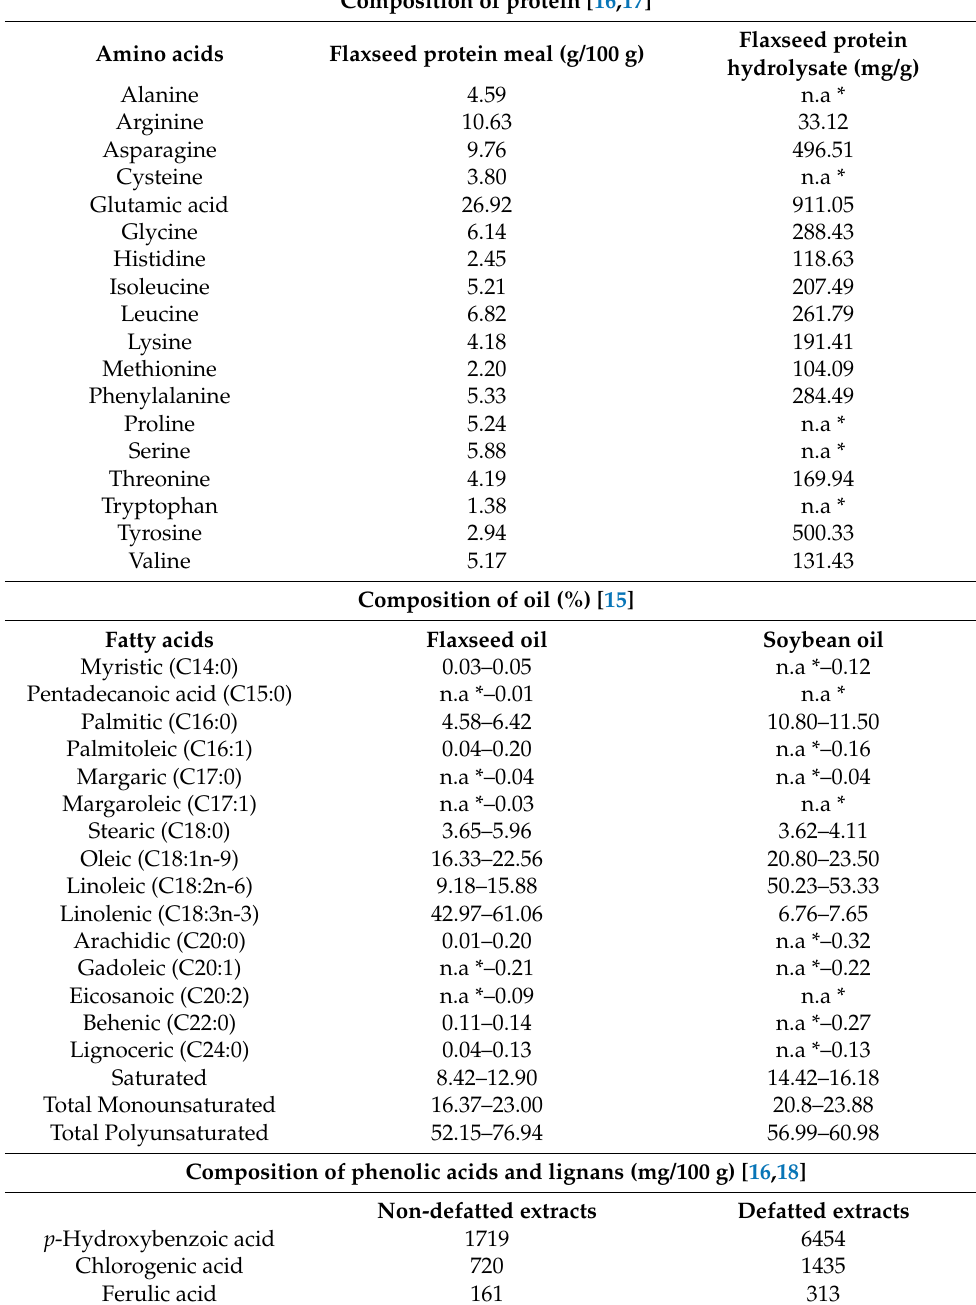
Table 1. Protein, oil, and phenolic acid composition of